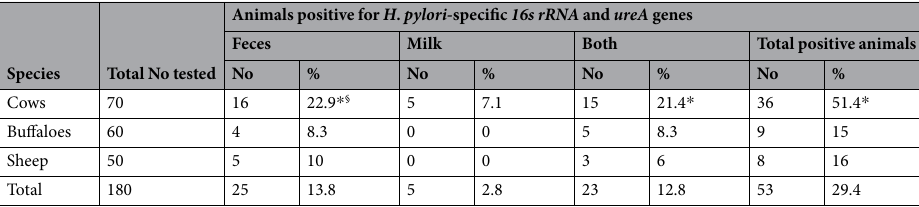
Table 2. Occurrence of Helicobacter pylori among livestock using PCR targeting H . pylori -specific 16s and ureA genes. * Indicates significant difference from the other species of animals with a p value of 0.00253 using a chi - square test. § Indicates significant difference from milk within the same animal with a p value of 0.03 using McNemar